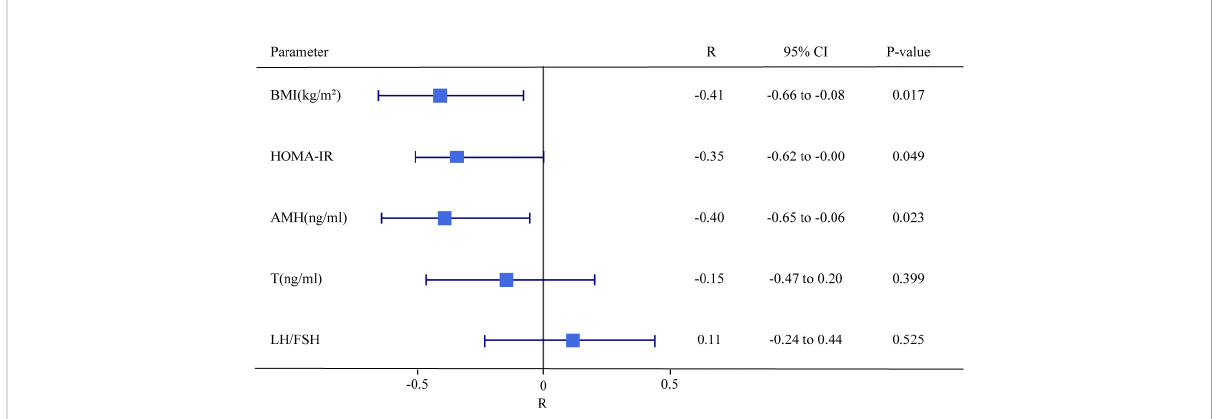
FIGURE 2 Forest plot of the Pearson Correlation between frequencies of MAIT cells of T cells and BMI, HOMI-IR, AMH, T, and LH/FSH in PCOS patients. P < 0.05 is considered as signi fi cantly